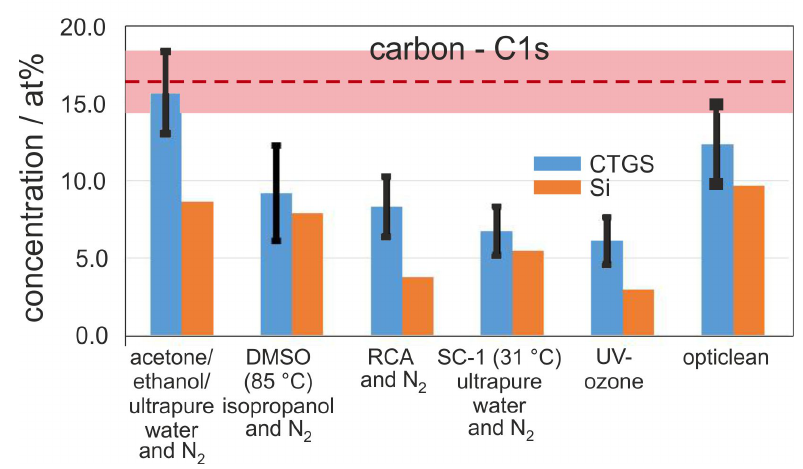
Figure 1. Mean value of carbon concentration from residual hydrocarbon surface contamination after the respective cleaning procedure measured with X-ray photoelectron spectroscopy (XPS) (Al-source with neutralizer) on the Ca 3 TaGa 3 Si 2 O 14 (CTGS) surface and on silicon reference. The red dashed line shows the mean carbon value of the unclean CTGS reference samples of about 17 at % C. The light red stripe indicates the corresponding standard deviation of 2.0 at